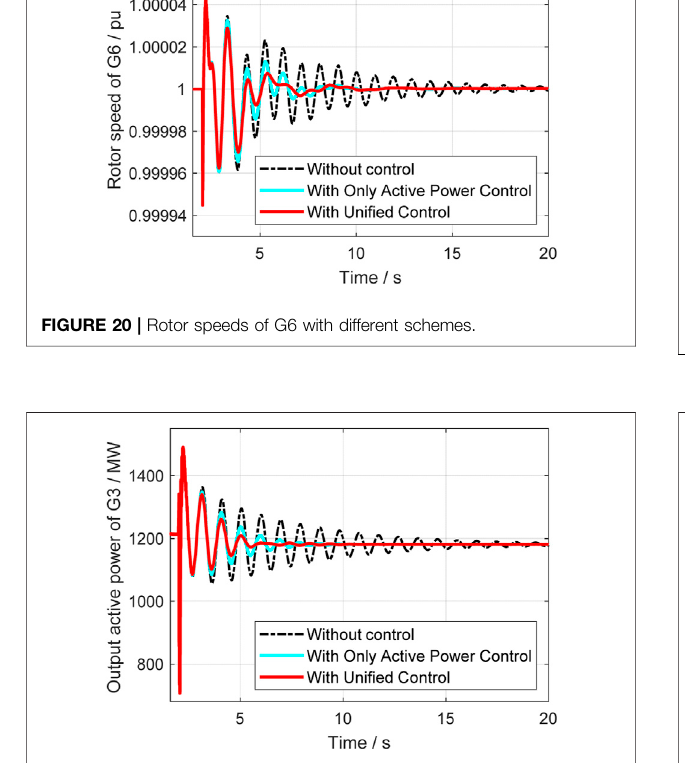
FIGURE 21 | Active power of G3 with different schemes.